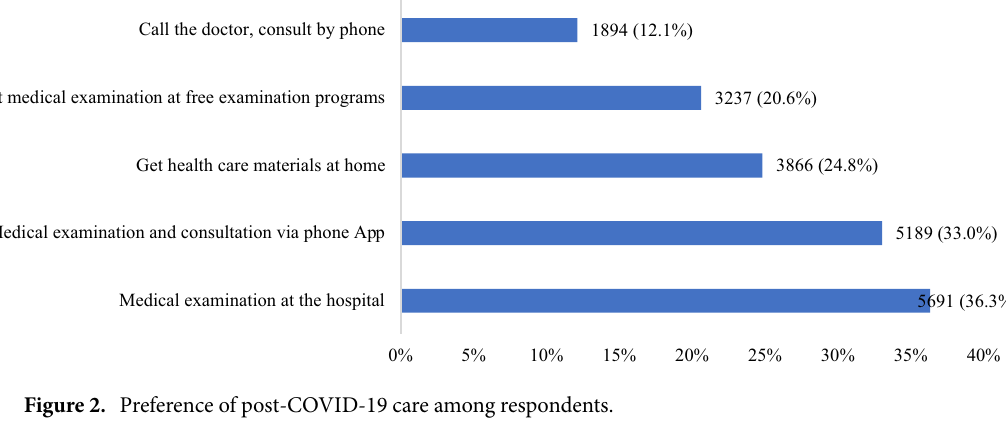
Figure 2. Preference of post-COVID-19 care among